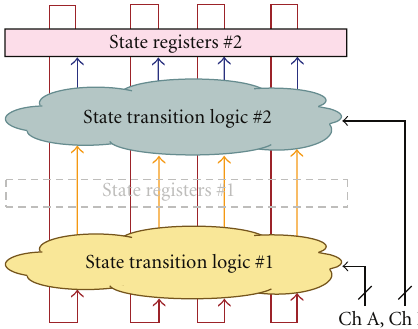
Figure 7: The construction of a 2-character matching circuit.